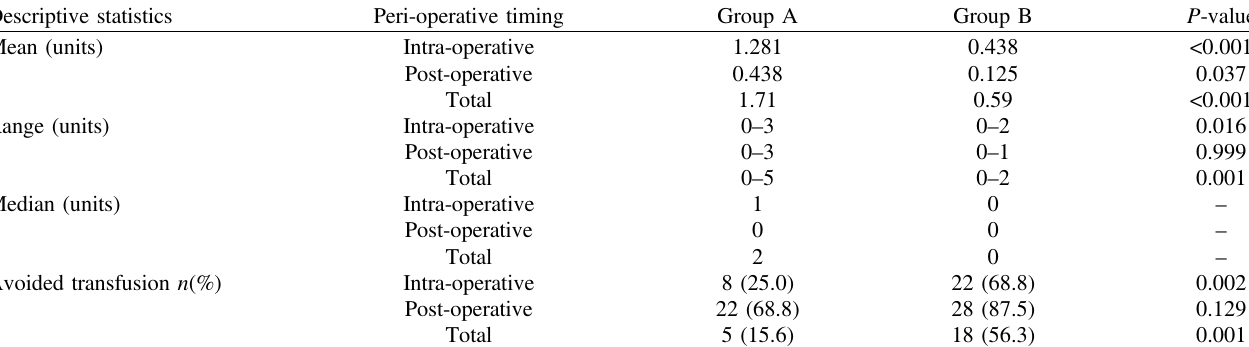
Table 2. Descriptive statistics of pediatric patients in terms of unit usage and transfusion avoidance.